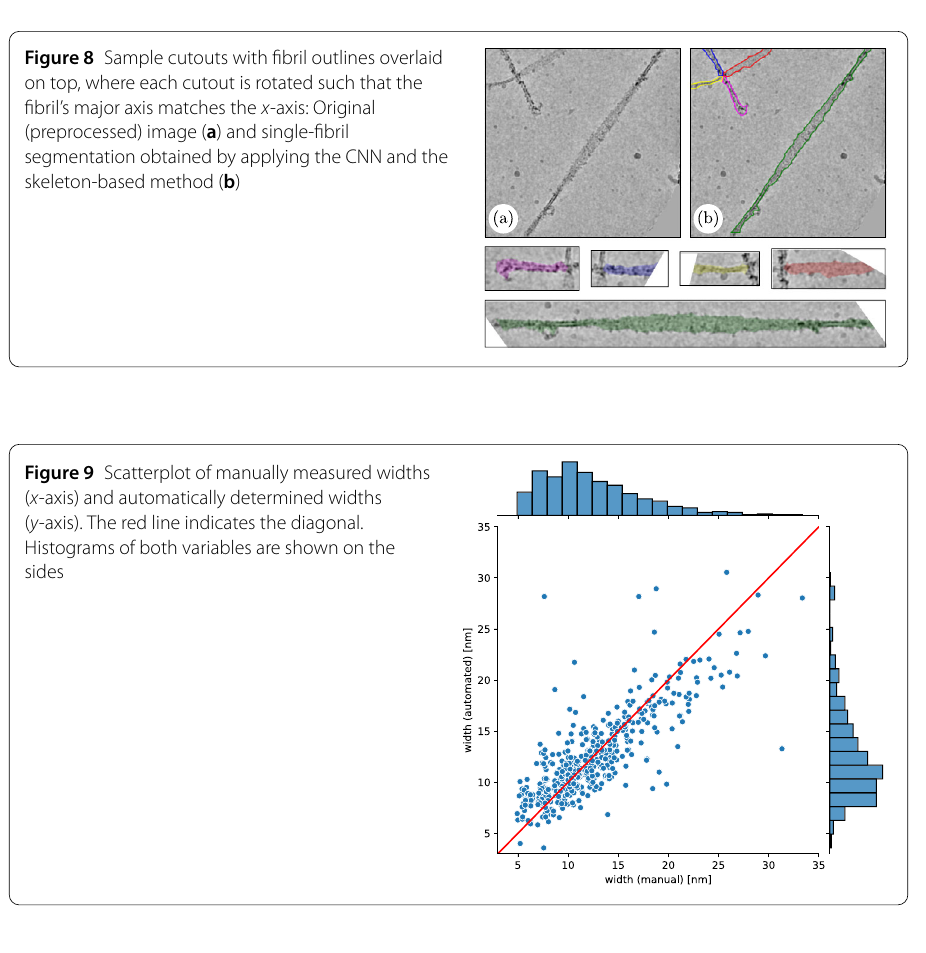
Figure 8 Sample cutouts with fibril outlines overlaid on top, where each cutout is rotated such that the fibril’s major axis matches the x -axis: Original (preprocessed) image ( a ) and single-fibril segmentation obtained by applying the CNN and the skeleton-based method ( b )